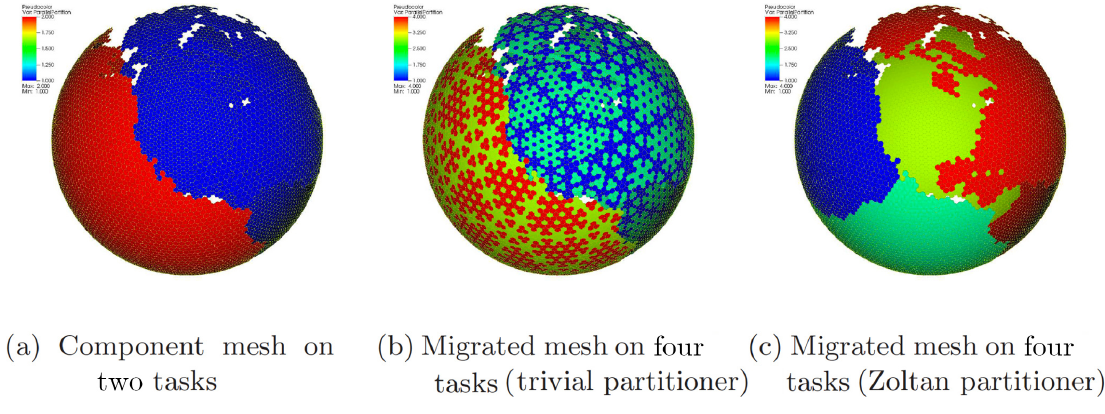
Figure 5. Migration strategies to repartition from N c to N x .